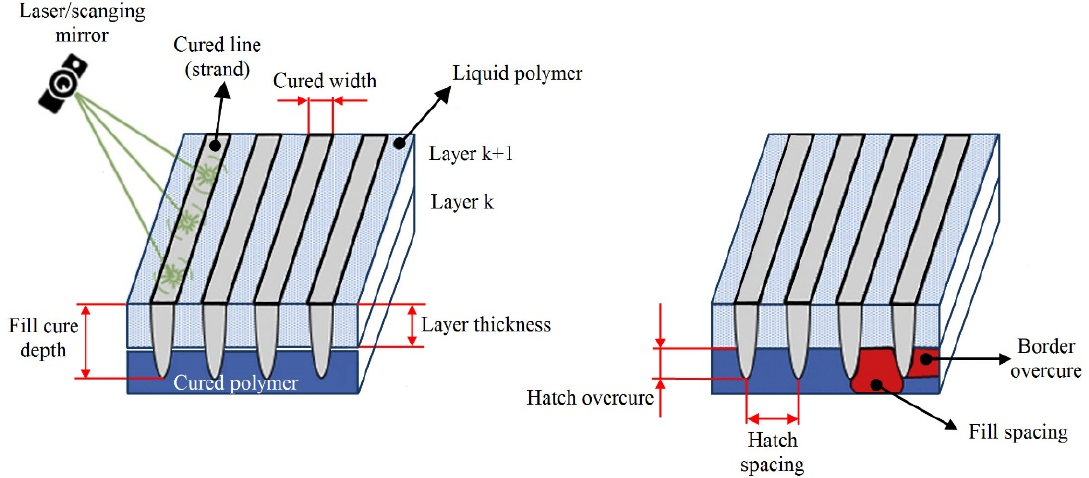
Figure 14. Build parameters of the SLA process [100].